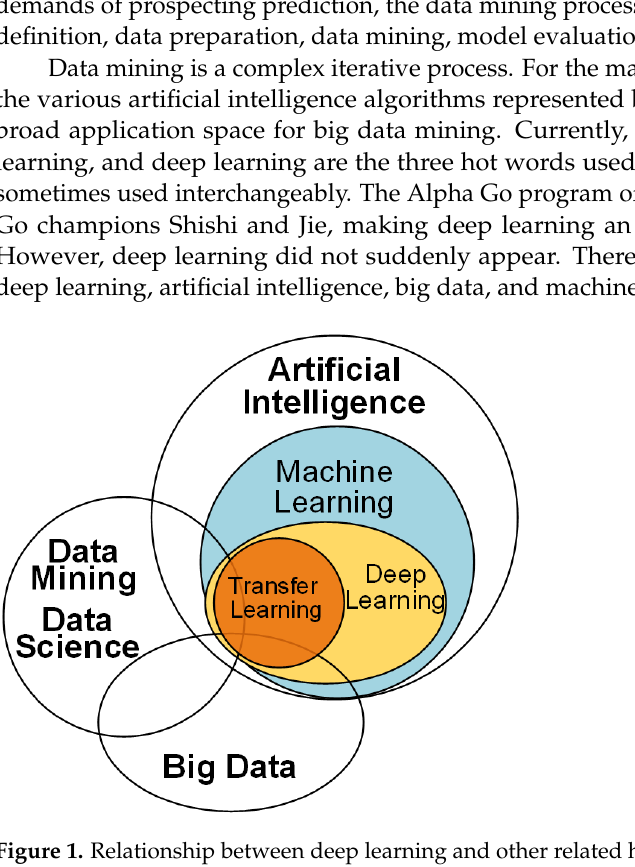
Figure 1. Relationship between deep learning and other related hot